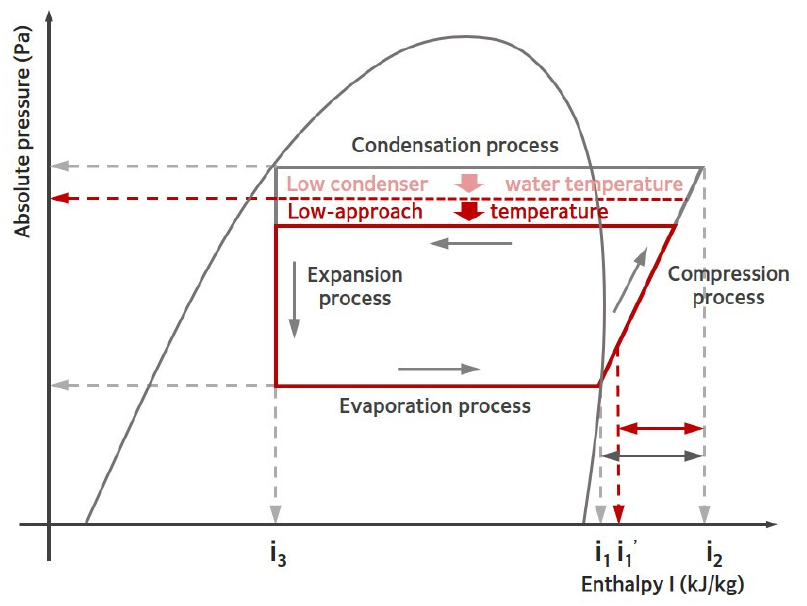
Figure 2. Mollier diagram with low-condenser water temperature.